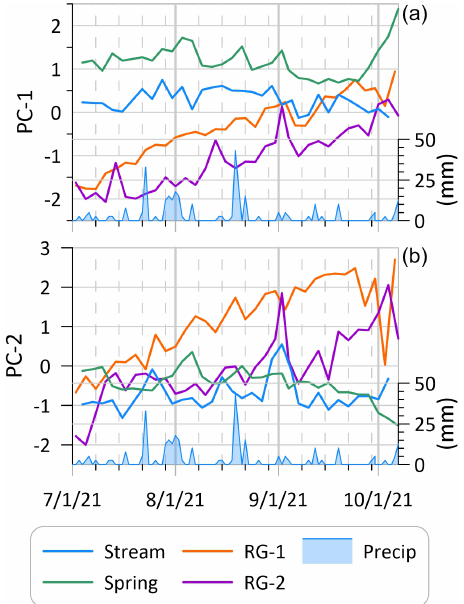
Figure 8. Time series of the first and second principal components presented in Fig. 7. Values tend to be stable through the melt season at the Stream and Spring but rise notably at both the rock glacier